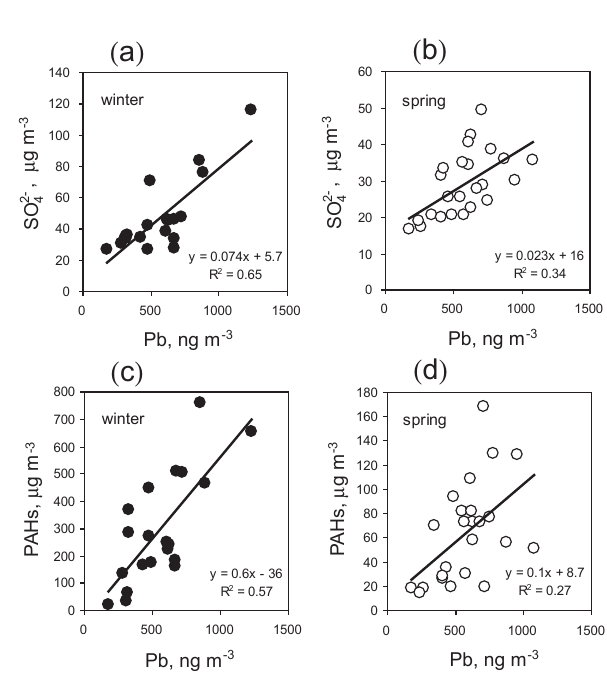
Fig. 7. Correlation of Pb with sulfate and PAHs in the PM 10 of Baoji city during winter and spring (Sulfate data are cited from Wang et al. (2009a), and PAH data are cited from Xie et al. (2009)). Figure 7. Correlation of Pb with sulfate and PAHs during winter and spring can largely be attributed to aerosol photochemical aging, al- though initial δ 13 C values of the carbonaceous aerosols de- pend on their sources. Such an enrichment in 13 C caused by photochemical aging was also observed for dicarboxylic acid aerosols from remote marine (Wang and Kawamura, 2006) and East Asia continent (Aggarwal and Kawamura, 2008). Solid-phase NH + and NO − are formed via adsorp- 4 3 tion/condensation of gaseous NH 3 and HNO 3 onto pre- existing particles (Seinfeld and Pandis, 1998), favoring an enrichment of light 14 N in particles (Hoefs, 1997;